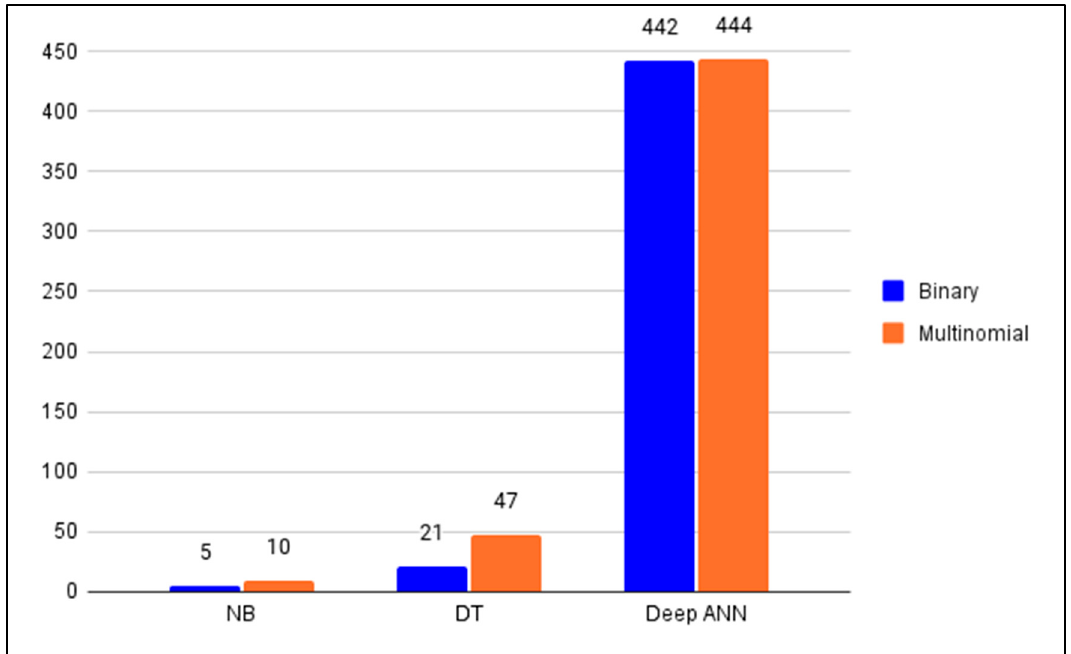
Figure 10. Anomaly detectors’ memory size (kB).